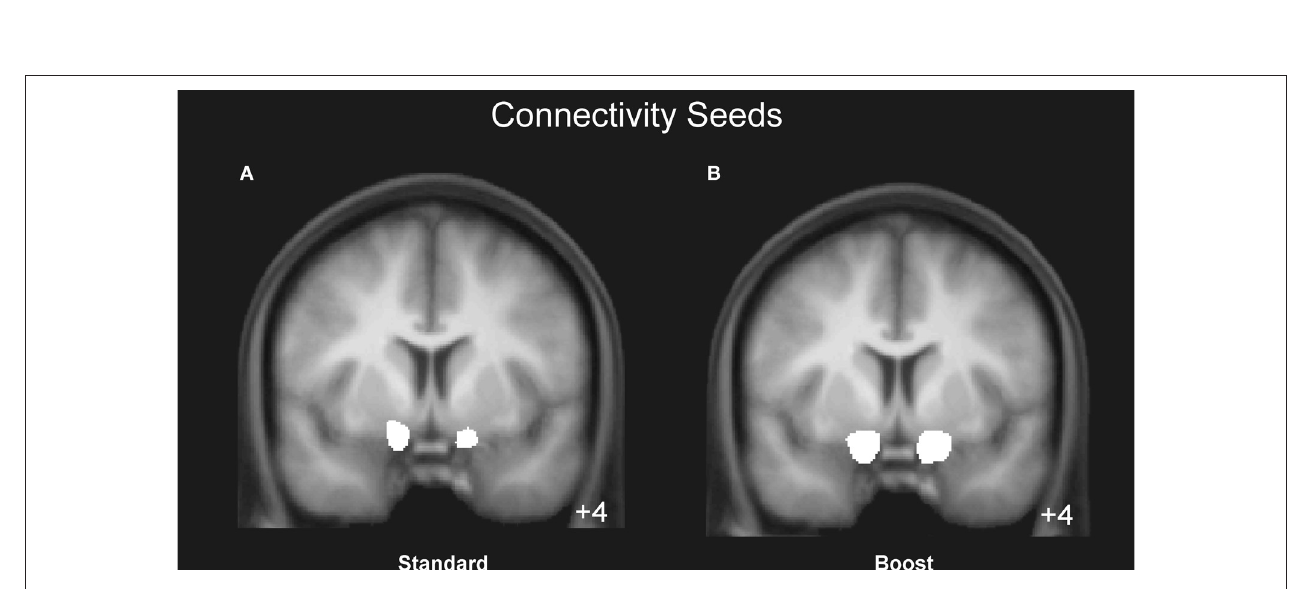
FIGURE 3 | Mean region of interest for the boost and standard condition. The left and right NAcc ROI was functionally defi ned for each participant in native space by identifying the statistically signifi cant activation cluster in the Gain (5 + 25) vs. Loss (5 + 25) and in the Gain (125) vs. Loss (125)